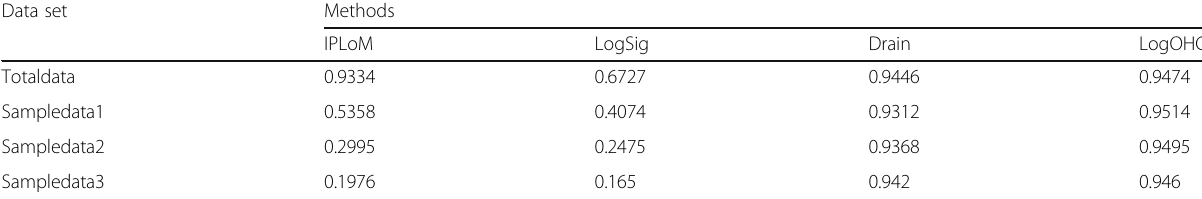
Table 2 F1-score on multi-source log data sets with four methods Data set